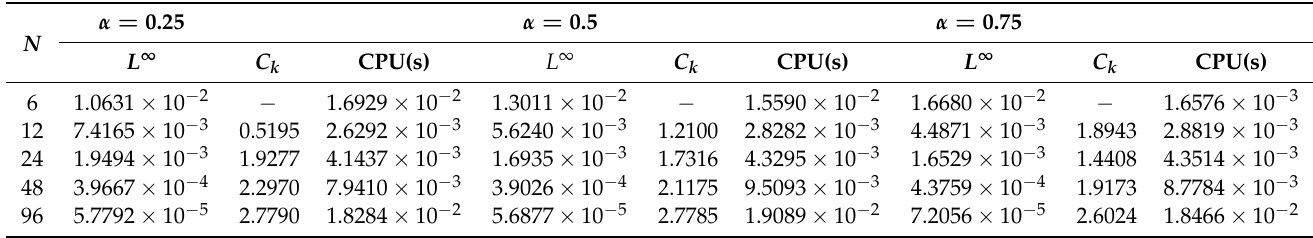
Table 4. The maximum norm errors L ∞ and temporal convergence rates C k with h = k .